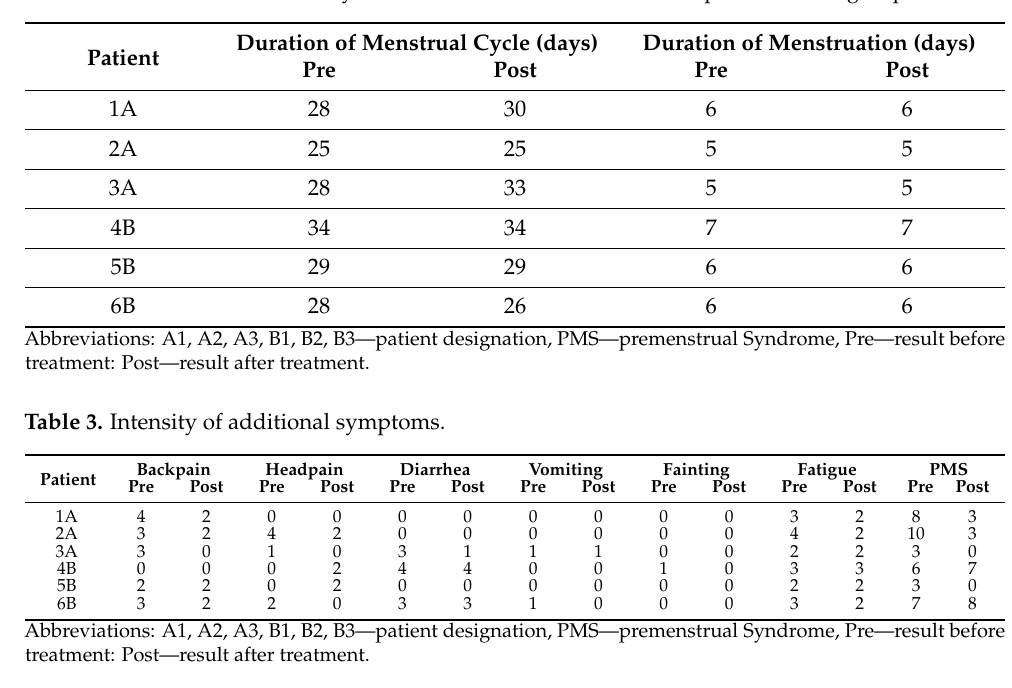
Table 4. Concentration of progesterone and estradiol 17-beta in patients in subgroup A and